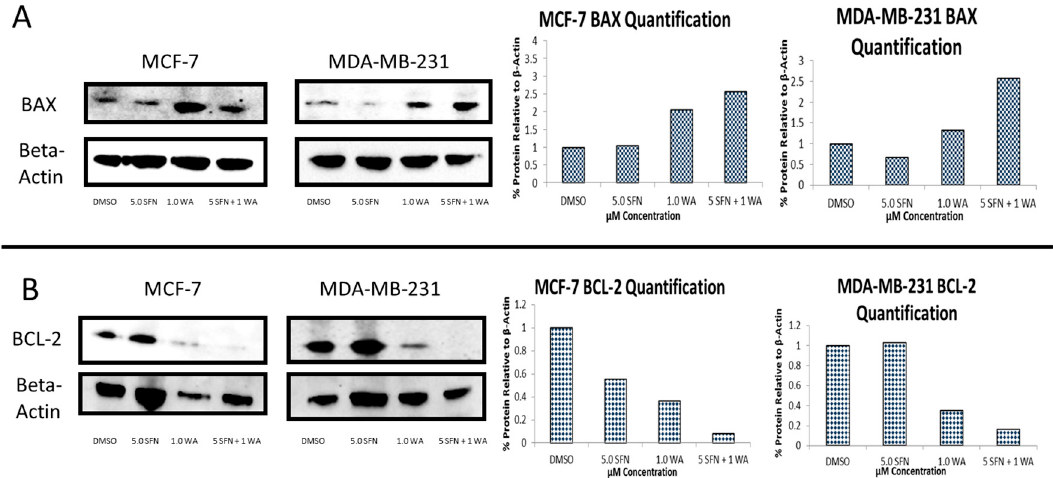
Figure 8. Combinatorial WA and SFN induce changes in the protein expression of the pro-apoptotic BCL-2 and anti-apoptotic BAX. ( A ) BAX protein expression in both MCF-7 and MDA-MB-231 cells is induced with the incorporation of the natural compounds. Image is representative and quantification is indicative of the averages of three different blots; ( B ) BCL-2 protein expression in both MCF-7 and MDA-MB-231 is reduced with the incorporation of the natural compounds. Image is representative and quantification is indicative of the averages of three different blots.